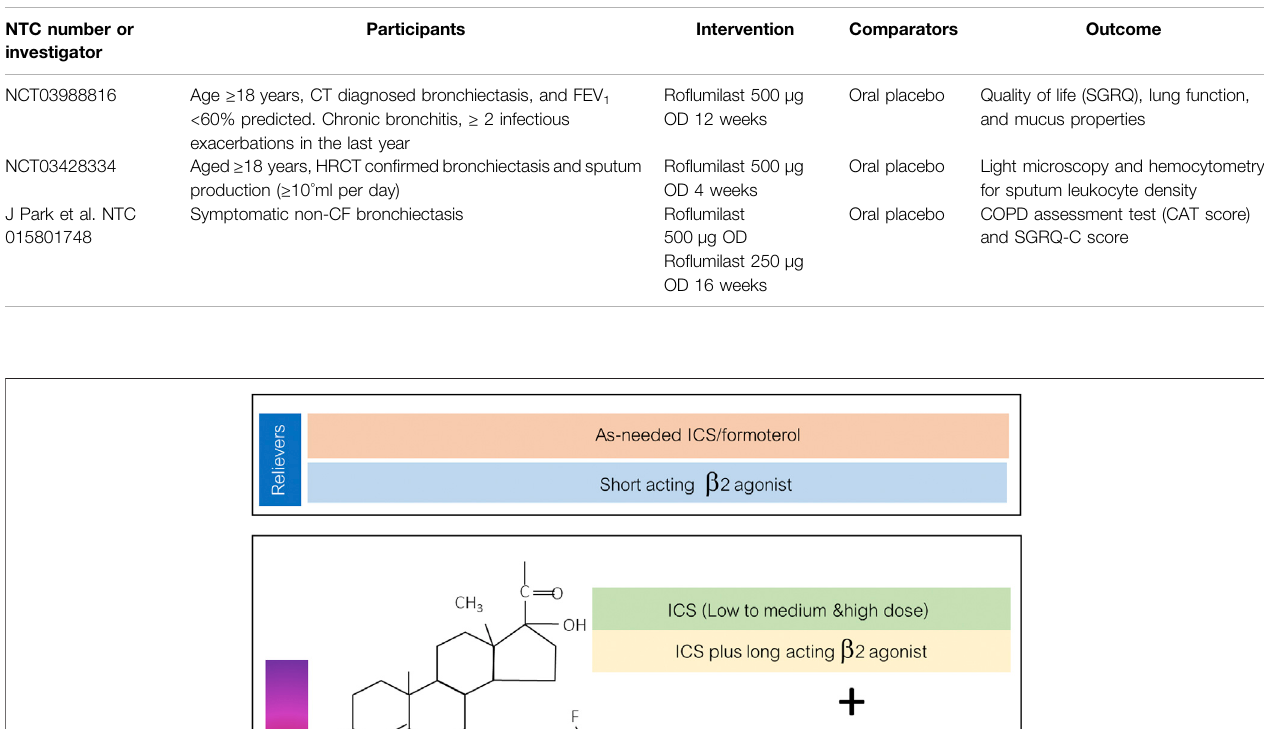
TABLE 4 | Clinical ef fi cacy of ro fl umilast on noncystic fi brosis bronchiectasis patients in clinical trials.